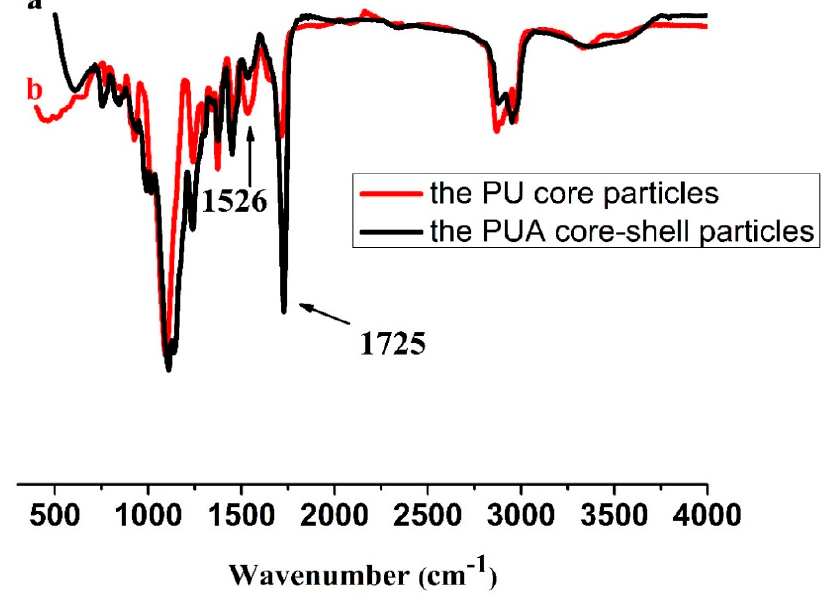
Figure 3. HR-TEM images of core-shell-structured latex particles.